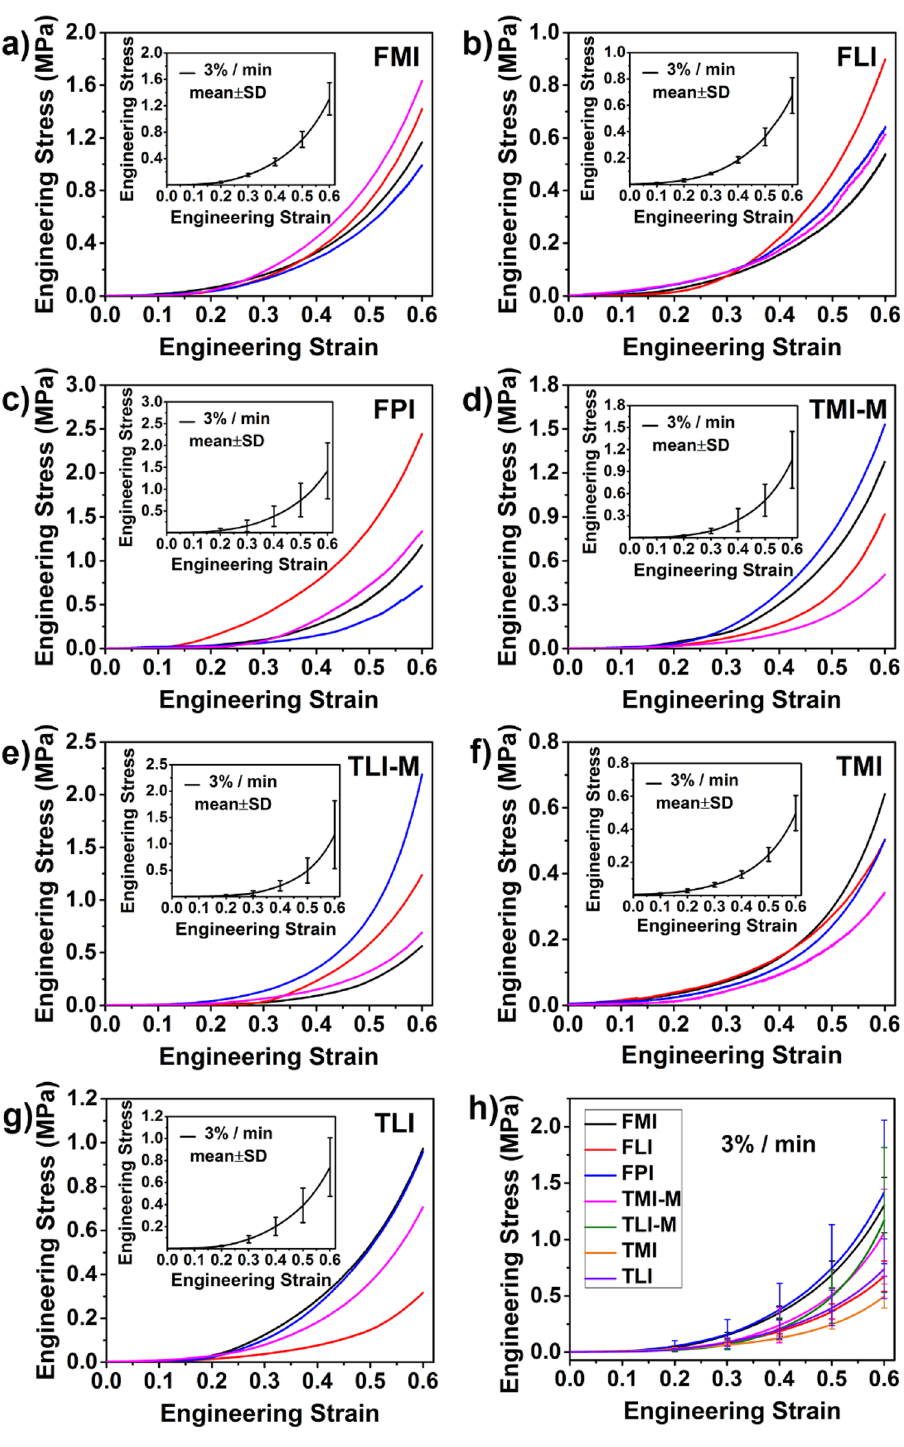
Figure 2. ( a – g ) Stress–strain curves of cartilage in predetermined regions at strain rate 3%/min. Inset: mean of four repetitions with error bar (± SD). ( h ) The comparison of mean stress–strain curves for seven regions at strain rate